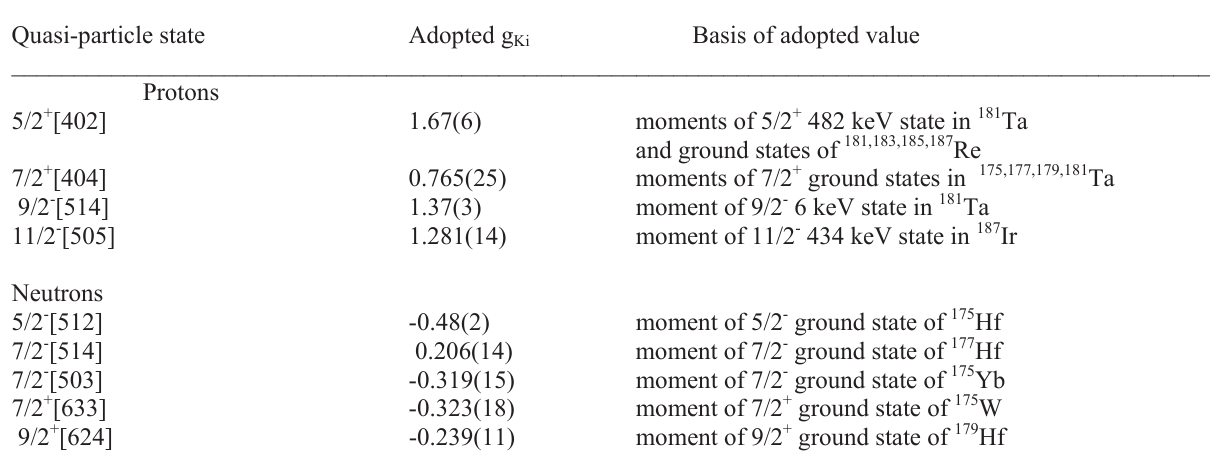
Table 1. Adopted g Ki values for individual quasi-particle states. Experimental moments taken from [10] with g R = 0.29(5). _